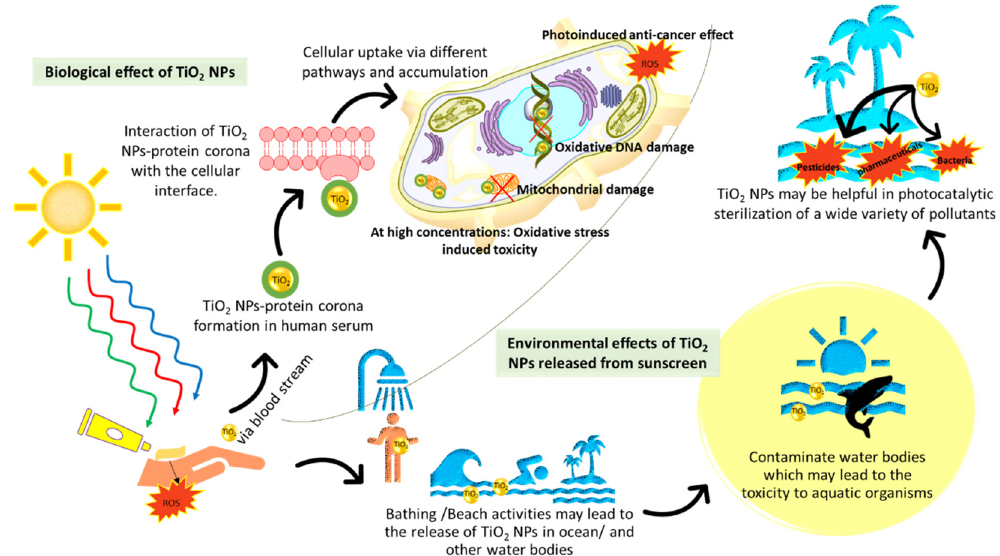
Figure 1. Environmental and biological e ff ects of the application of TiO 2 nanoparticles (NPs) in sunscreen. The NPs can pollute water bodies and possibly hurt aquatic life, but also serve a beneficial photocatalytic sterilization function. In humans, the NPs may translocate into the body. There is evidence for proteins forming a protein corona around the NPs and influencing their cellular uptake. There are several UV and non-UV debilitating cellular e ff ects caused by TiO 2 NPs. In both water bodies and humans, NP solubilization can occur, which produces Ti(IV) ions (not depicted) and e ff ects similar to the NPs.